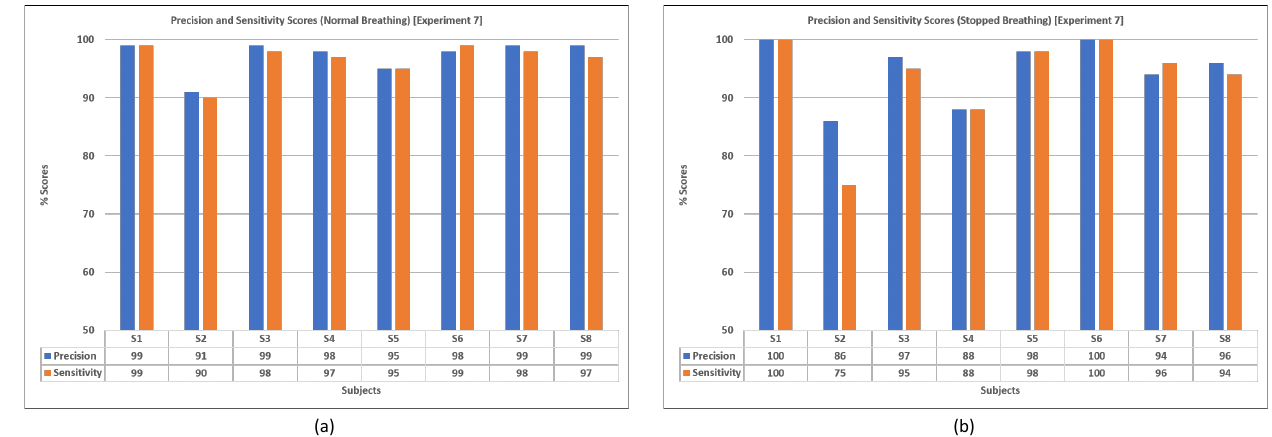
Figure 11. Precision and sensitivity values of ( a ) Experiment 7 (normal breathing state), ( b ) Experiment 7 (stopped breathing state).